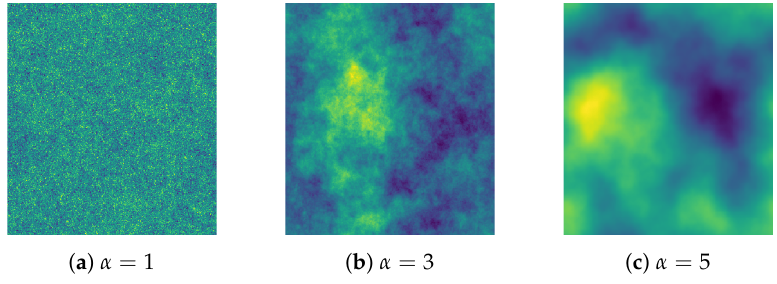
Figure 1. Gaussian Random Fields for various α ’s.